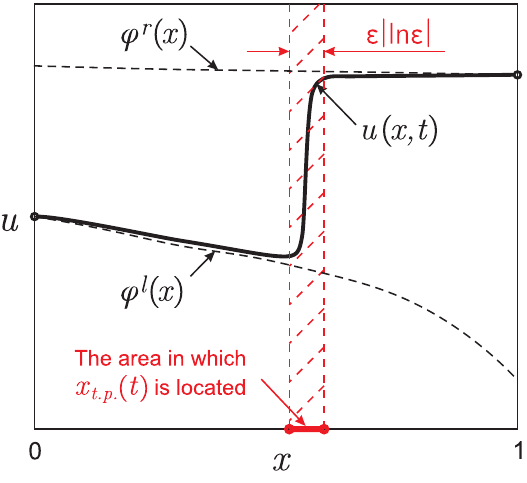
Figure 1. Typical form of the moving front-type solution in Problem (1) for a fixed t . The figure is drawn for set of parameters (16) and time t (cid:39)